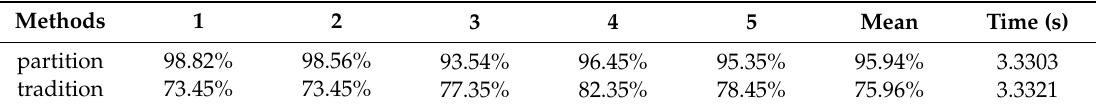
Table 1. Accuracy rates and detection time comparison of partition and traditional unpartitioned detection results.